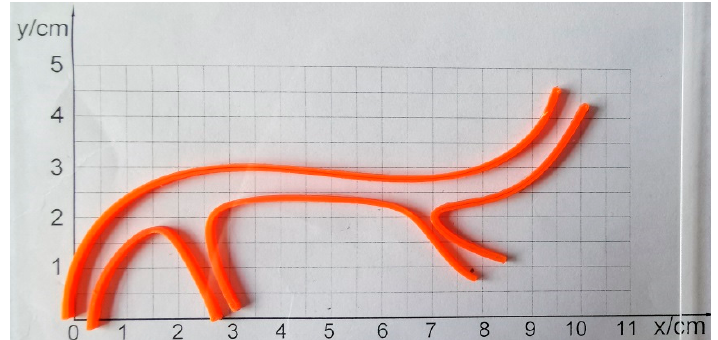
Figure 11. The experimental platform.